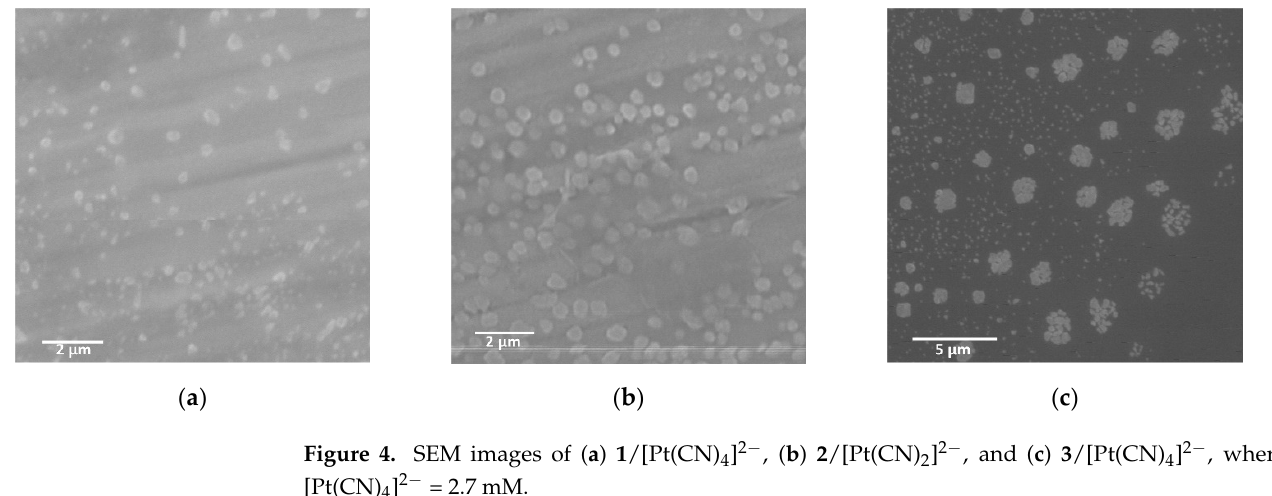
Figure 4. SEM images of ( a ) 1 /[Pt(CN) 4 ] 2− , ( b ) 2 /[Pt(CN) 2 ] 2− , and ( c ) 3 /[Pt(CN) 4 ] 2− , where [Pt(CN) 4 ] 2− = 2.7 mM.